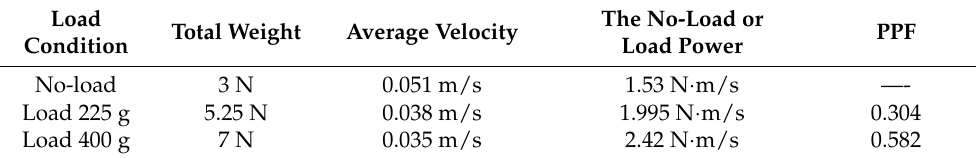
Table 3. The no-load or load power of a module unit of the ISB-MWCR under three conditions.